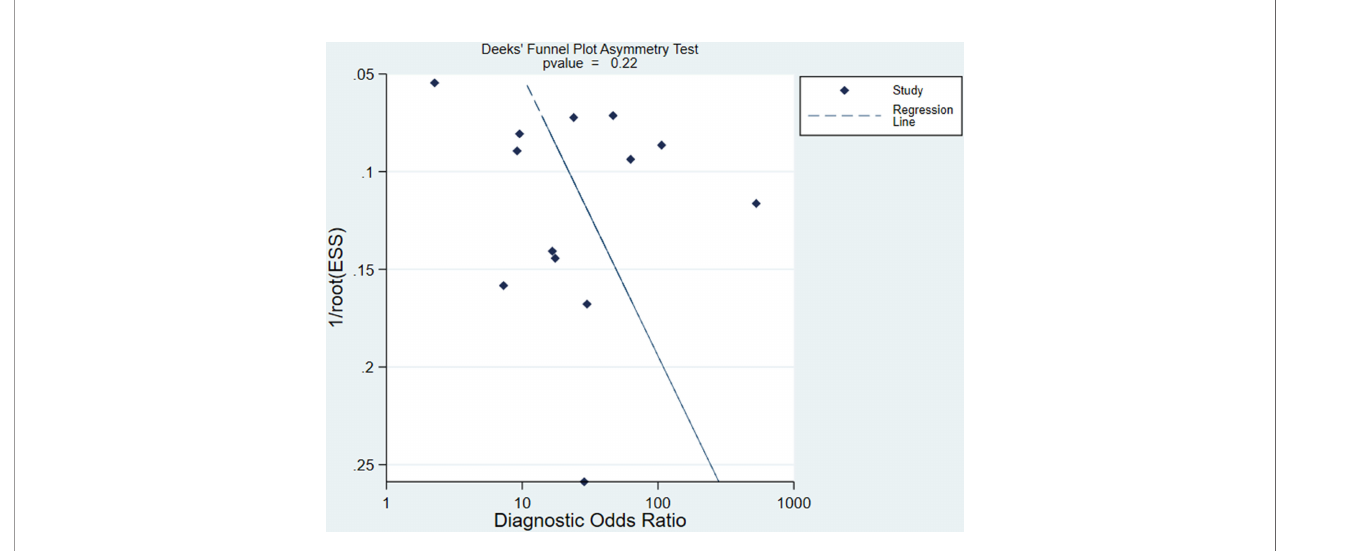
FIGURE 5 | Deeks funnel plot shows the likelihood of publication bias is low with a P value of 0.22. ESS, effective sample size.